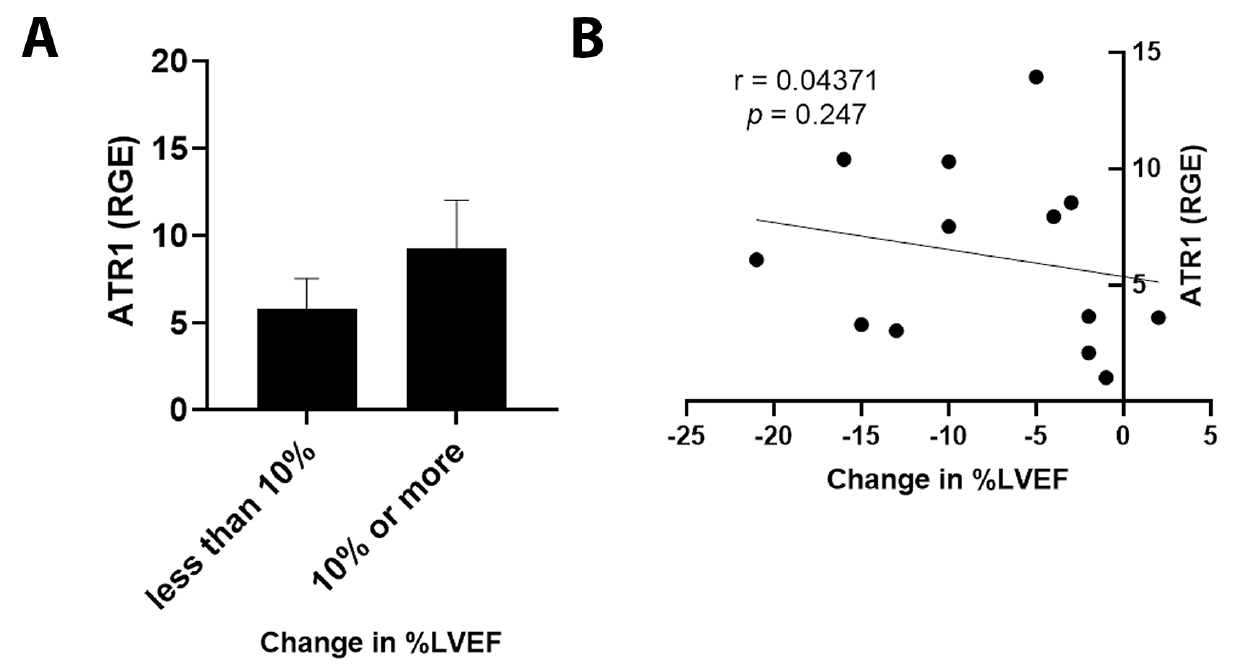
Figure 10. Relationship between change in percentage of LVEF <10% or ≥10% and ATR1. ( A ) Rela- tive gene expression (RGE) of ATR1 by qRT-PCR ( p = 0.153) compared to the housekeeping gene PUM1. ( B ) Pearson correlation for ATR1 expression vs. change in percentage of LVEF ( p = 0.247). n = 13. Table 2. Relationship between LVEF of >55% or ≤50% and genes of interest using different house- keeping genes in tumor samples.